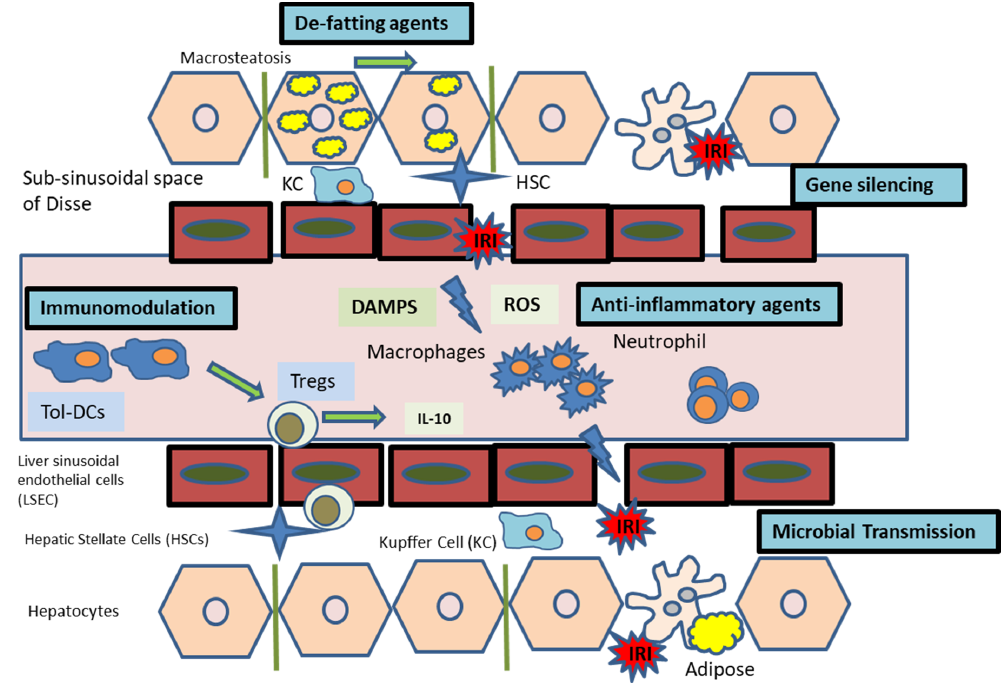
Figure 1. Overview of interventions during NMP for IRI.